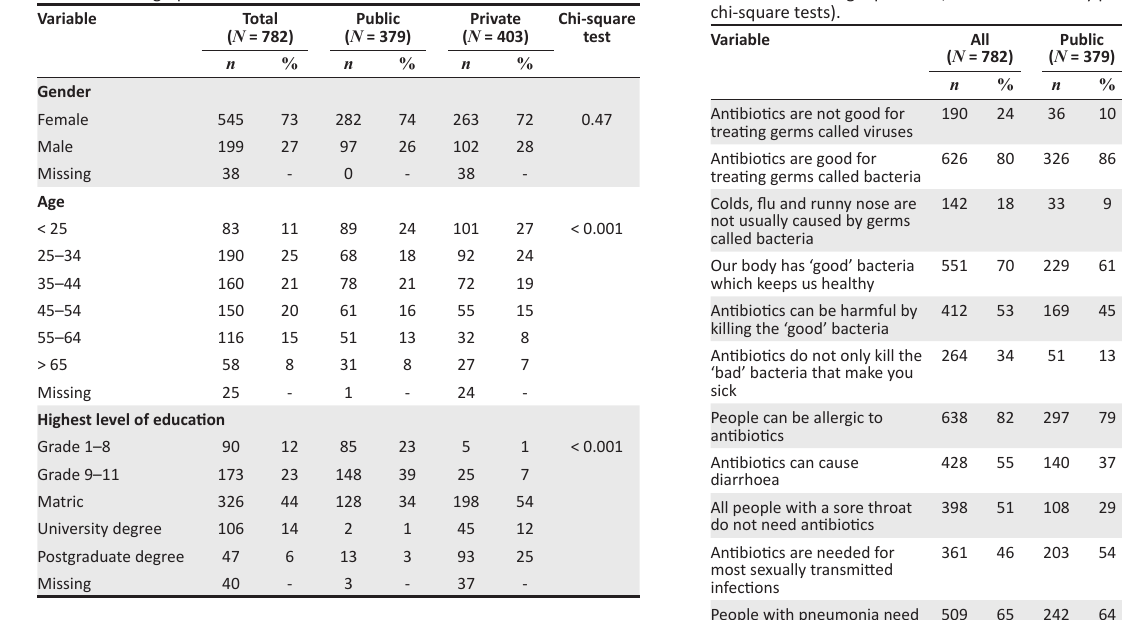
TABLE 1: Demographic